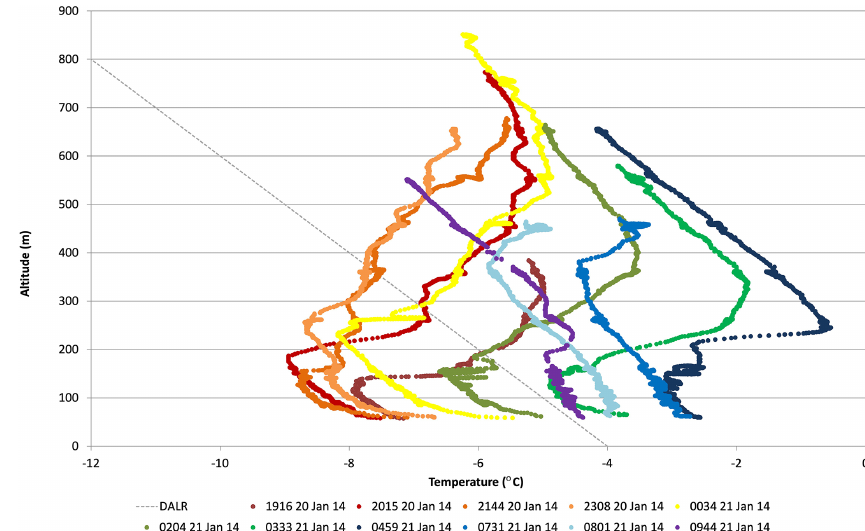
Figure 4. SUMO observed temperature profiles (plotted as colored lines) at the Ross Ice Shelf Tall Tower AWS site from 19:16UTC, 20 January 2014, to 09:44UTC, 21 January 2014. The dry adiabatic lapse rate (DALR) is shown with a dashed gray line.